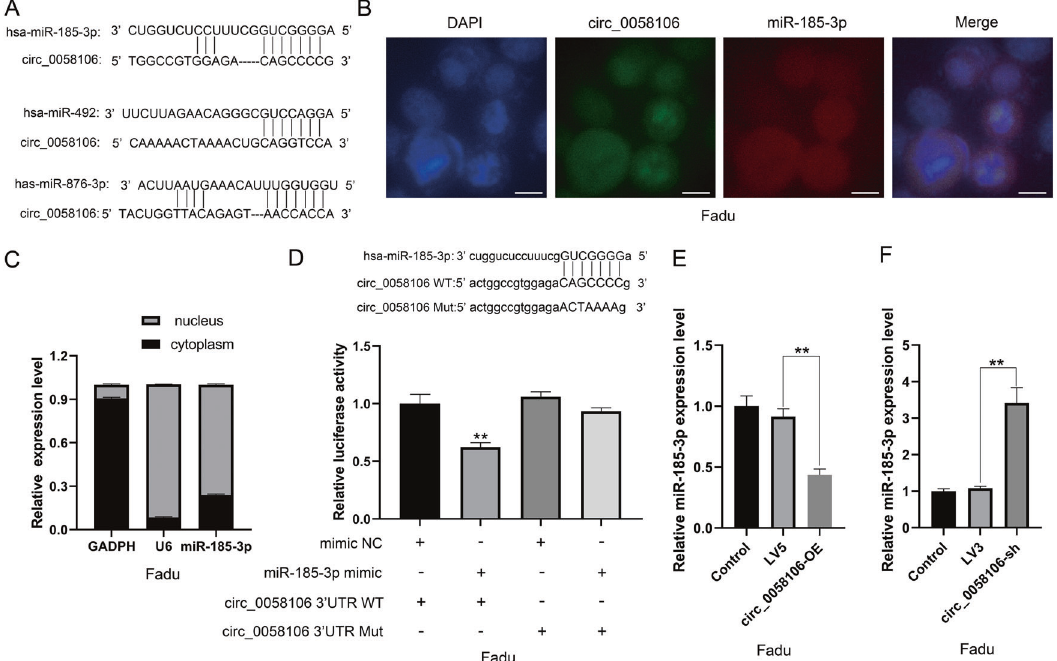
Fig. 6 circ_0058106 binds miR-185-3p and regulates miR-185-3p expression in HSCC cells. A Sequence alignments between circ_0058106 and seed sequences of miRNAs. B FISH for subcellular localization of circ_0058106 and miR-185-3p by using 5 ′ -CY3 labeled circ_0058106 FISH probe and 5 ′ -FAM labeled miR-185-3p FISH probe, DAPI stained cell nuclei. (Scale bars = 10 μ m) C qRT-PCR analysis indicated the distribution of GAPDH, U6 and miR-185-3p in the nucleus and cytoplasm of Fadu cells ( n = 3). D Dual-luciferase reporter gene assay was used to detect interaction between circ_0058106 and miR-185-3p. ( n = 3, * P < 0.05; ** P < 0.01) E miR-185-3p expression in circ_0058106-OE and LV5 Fadu cells were detected by qRT-PCR. ( n = 3, * P < 0.05; ** P < 0.01) F miR-185-3p expression in circ_0058106-sh and LV3 Fadu cells were detected by qRT- PCR. ( n = 3, * P < 0.05; ** P <